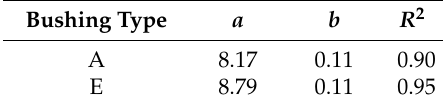
Table 2. The values of a , b , and R 2 for samples A and E.